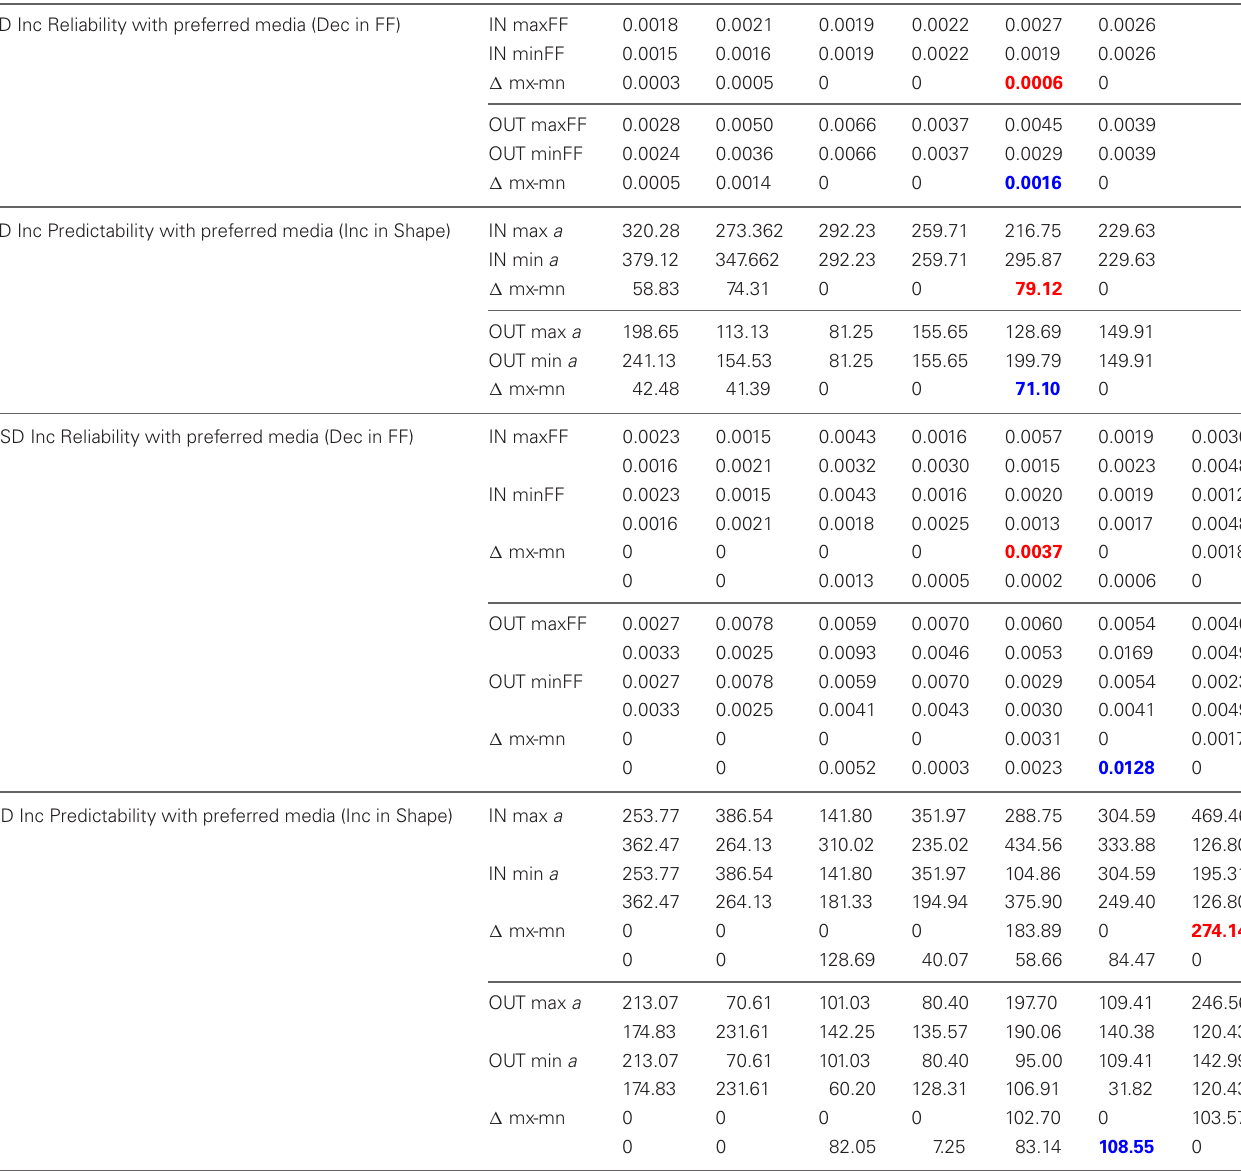
Table A3 | Reliability and Predictability of the experimentally estimated probability distributions for TD and ASD cases to assess the effectiveness of different media